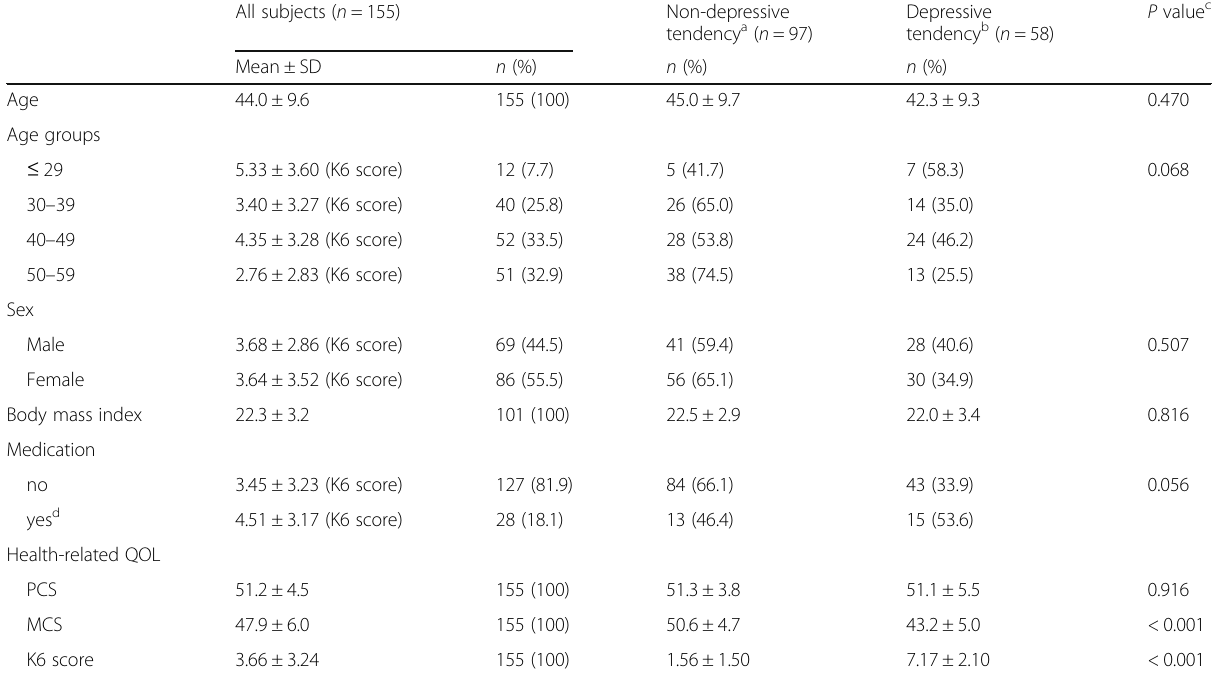
Table 1 Characteristics of the subjects All subjects ( n =